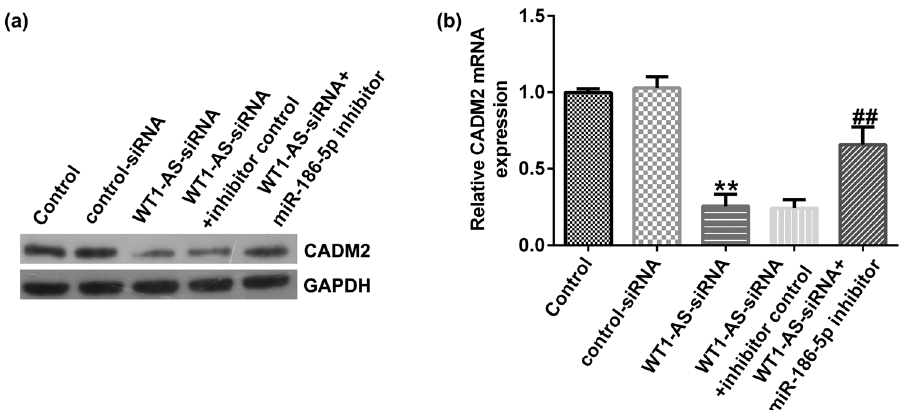
Figure 9: WT1 - AS - siRNA - reduced CADM2 expression in HTR - 8/SVneo cells. HTR - 8/SVneo cells were transfected with control siRNA, WT1 - AS siRNA, WT1 - AS siRNA + inhibitor control, or WT1 - AS siRNA + miR - 186 - 5p inhibitor. ( a ) Protein expression of CADM2 in HTR - 8/SVneo cells was determined using western blotting. ( b ) mRNA expression of CADM2 in HTR - 8/SVneo cells was determined using RT - qPCR. ** P < 0.01 vs control siRNA; ## P < 0.01 vs WT1 - AS siRNA + inhibitor control. WT1 - AS, WT1 antisense RNA; si, small interfering; miR, microRNA; RT - qPCR, reverse transcription - quantitative